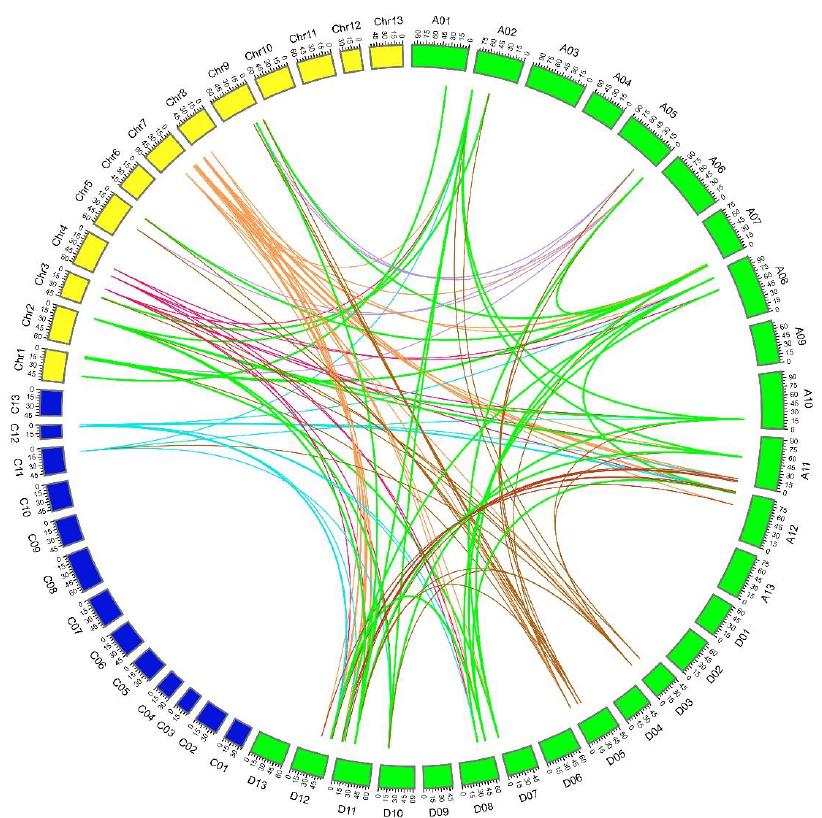
Figure 5. Circos map of 134 homologous ACS gene pairs among G. arboreum , G. raimondii , and G. hirsutum .